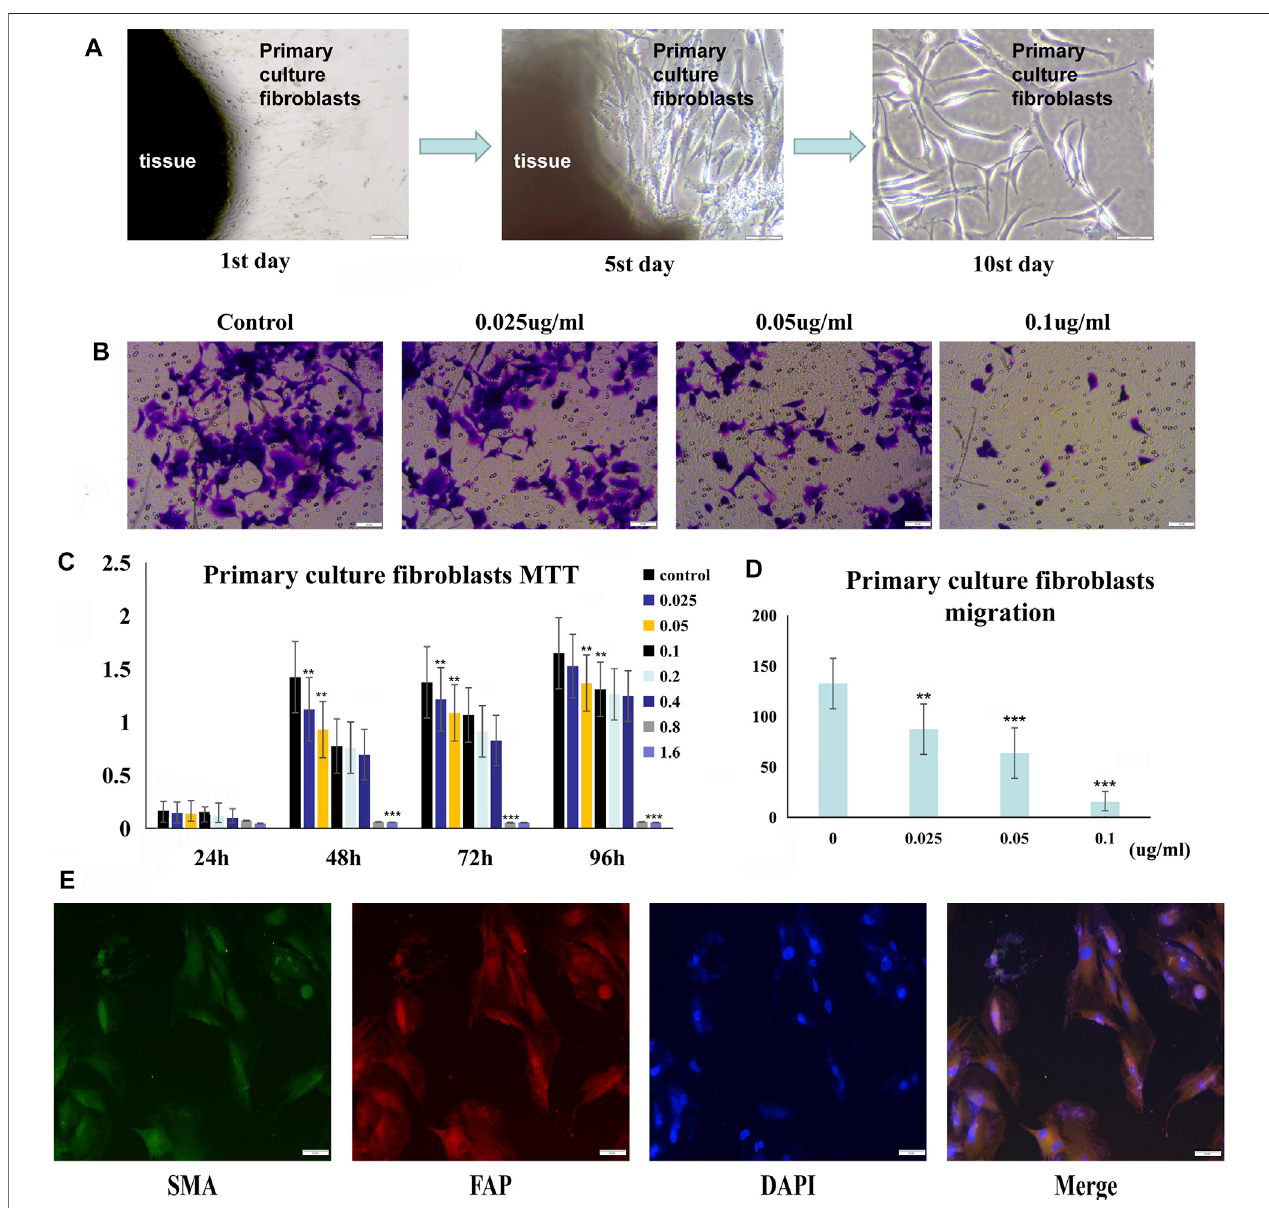
FIGURE 6 | PSII reduced the growth and motility of primary culture fi broblasts from head and neck tumor tissue. (A) The process of human squamous cell carcinoma primary culture fi broblasts as described in Materials and Methods. (B) The migration of cancer primary culture fi broblasts in a dose-dependent manner. (C) The MTT statistical fi gure of cancer primary culture fi broblasts in a dose- and time-dependent manner. (D) The migration statistical fi gure of cancer primary culture fi broblasts in a dose-dependent manner. (E) Immuno fl uorescence for identifying primary culture of fi broblasts. Cells were treated with the corresponding primary antibody against FAP, SMA, followed by incubation with appropriate secondary antibodies and all fi broblasts were stained with DAPI. Bars, 50 µm. All the experiments were carried out three times. The bar graphs and the table show quanti fi cation of the results, and each data represent the mean ± SD of three independent experiments (* p < 0.05; ** p < 0.01; *** p < 0.001 vs the control